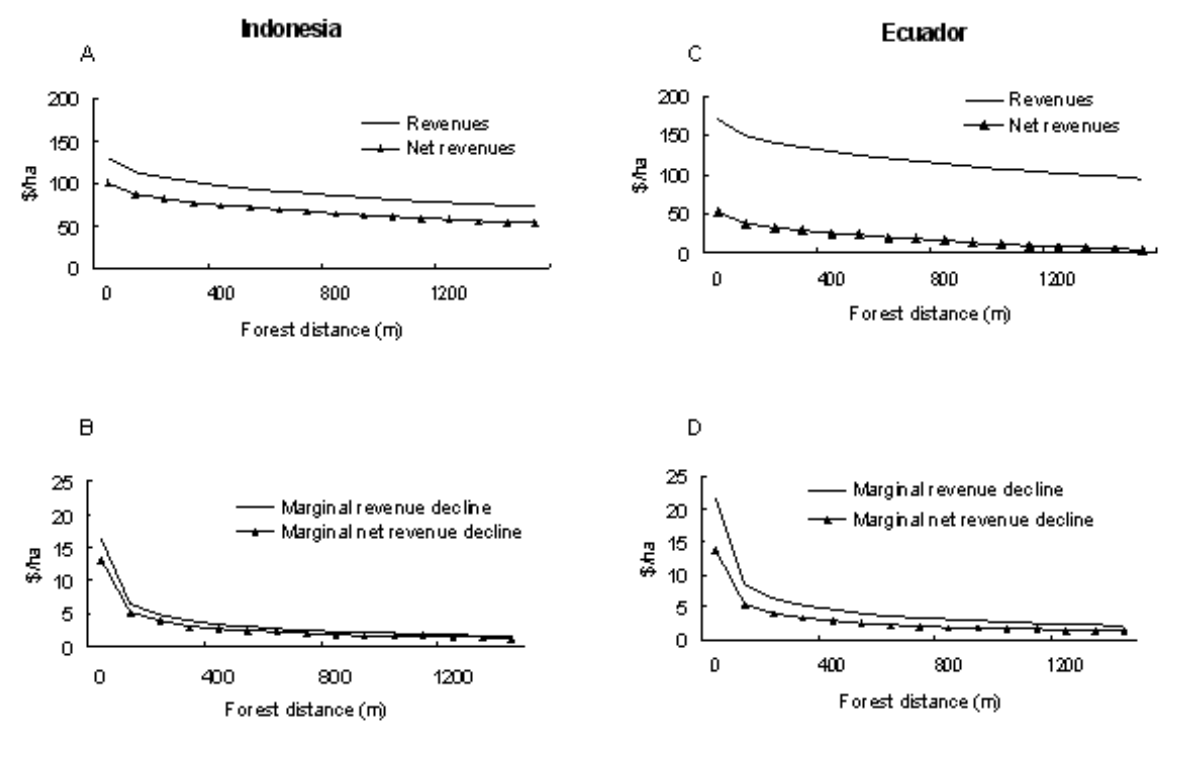
Fig. 2. Coffee revenues in relation to forest distance in Indonesia and Ecuador. (A) and (C), net revenues calculated as revenues minus costs for the combined effect of fruit set and berry weight (see Table 1); (B) and (D), marginal (net) revenue decline calculated as the (net) revenue reduction caused by 100-m stepwise increases in forest distance. All monetary values in